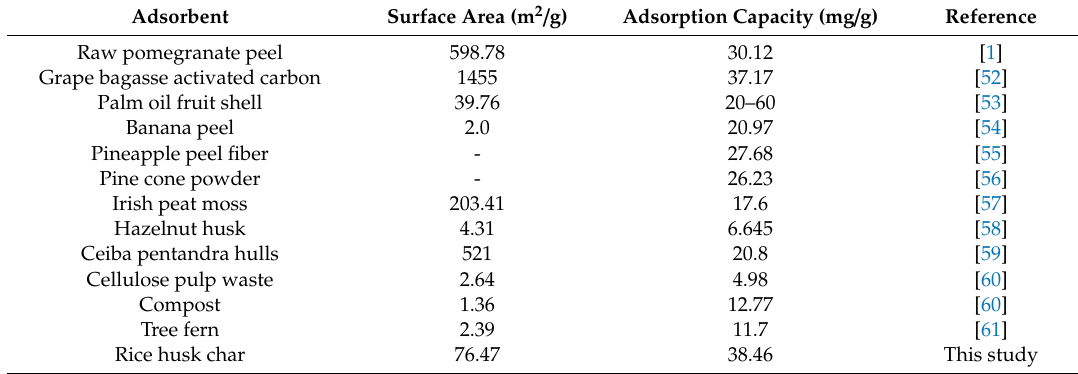
Table 5. Comparison of Cu(II) adsorption e ffi ciencies of di ff erent